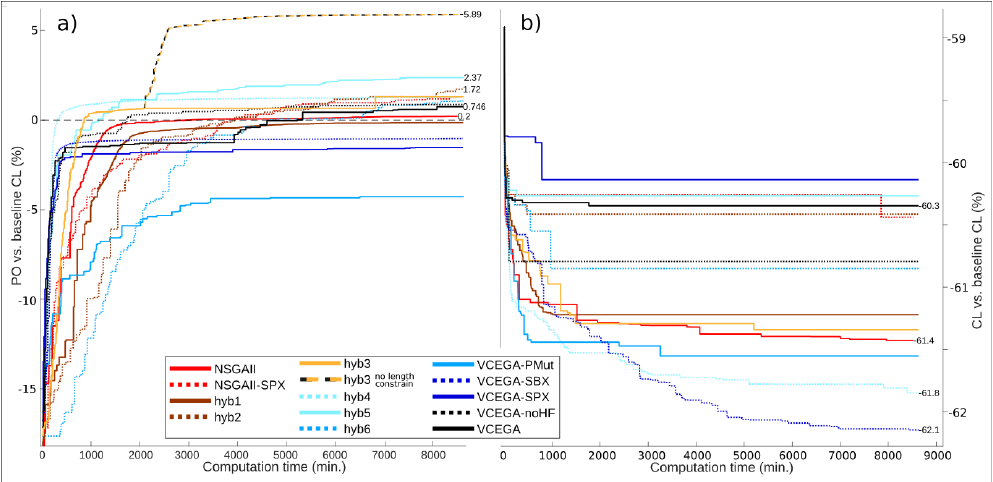
Figure 5. Evolution of the maximum PO ( a ) and minimum CL ( b ) obtained at each generation for the algorithms considered. Dashed black/orange line ( a ) shows the evolution of ‘hybrid3’ with no